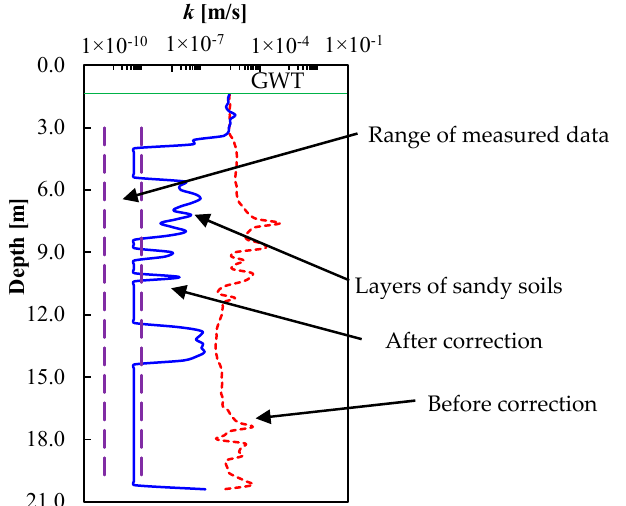
Figure 8. Measured and estimated hydraulic conductivity profile for Cowden, UK site.